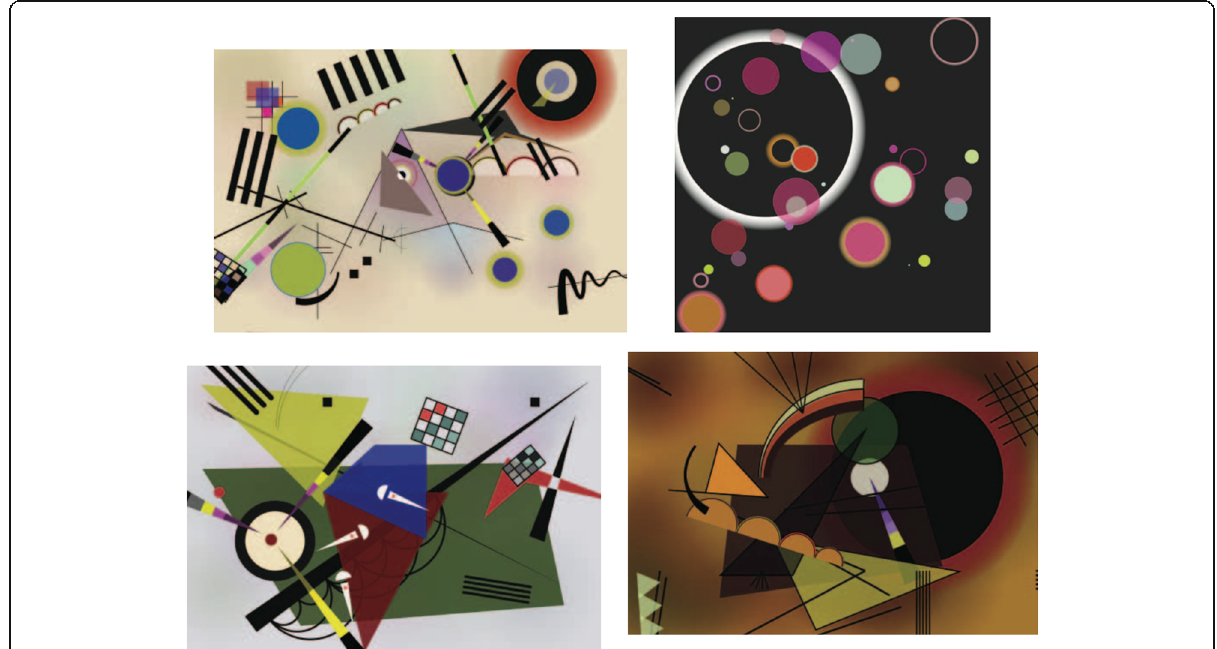
Fig. 20 Kandinsky ’ s styles automatically generated: “ Composition VIII ” (top left), “ Several Circles ” (top right), “ On White II ” (bottom left), “ Black and Violet ” (bottom right) [59]